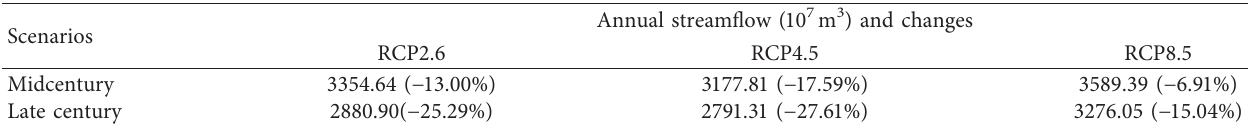
Figure 8: Annual cycle of the monthly mean streamflow for the ensemble mean of SWATsimulations in Station 3 with downscaled climate variables from five GCMs as inputs over the period of 1976–2000. Table 8: Statistics of annual runoff under three scenarios for the two future periods and their changes compared to that under the historical scenario.